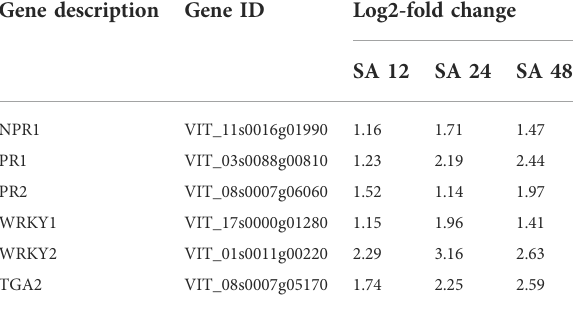
TABLE 4 DEGs involved in SA plant defense pathway after 12, 24, and 48 h of SA